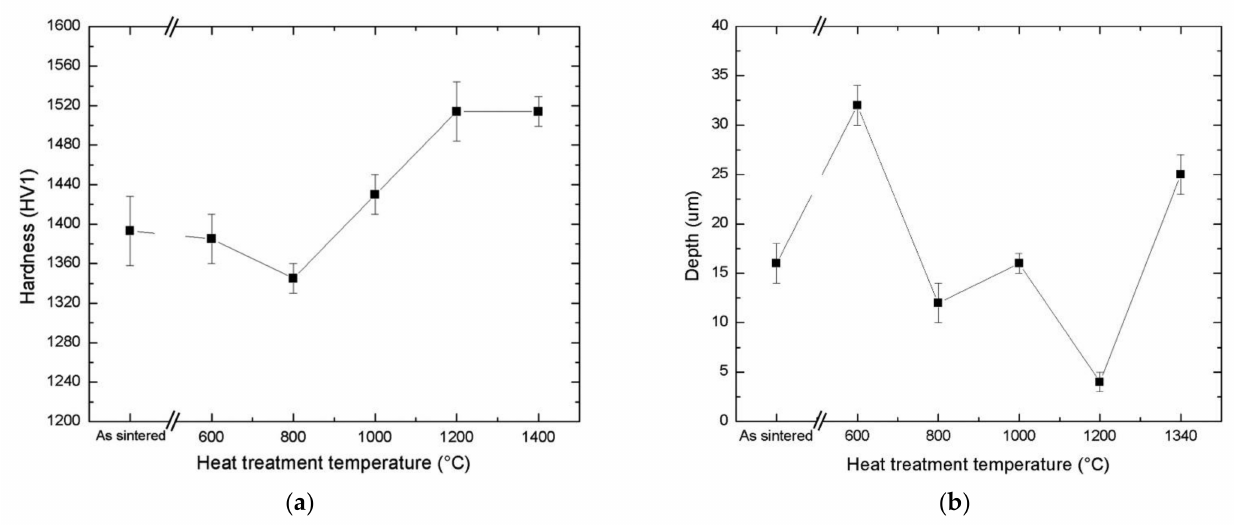
Figure 3. Measured hardness ( a ) and scratch depths (with 30 N applied load) ( b ) as a function of TiC-Ni 3 Al cermet processing conditions (as-sintered and ordering heat treatment at temperatures 600–1340 ◦ C)